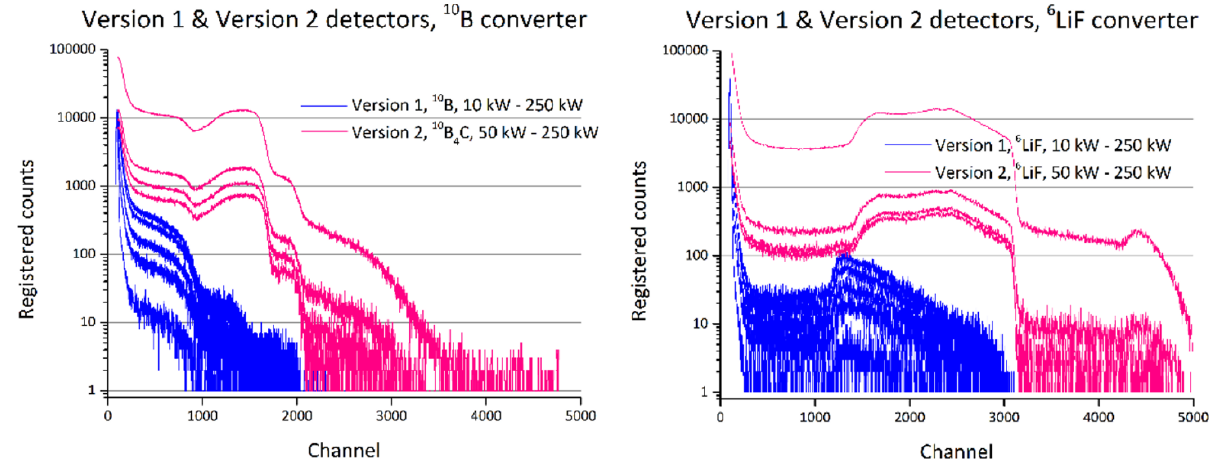
Figure 7: Registered particle spectra from E-SiCure SiC detectors. Version 1 detector spectra marked in blue, Version 2 spectra in pink. Left: measured spectra using 10 B / 10 B C converter, right: measured 4 spectra using 6 LiF